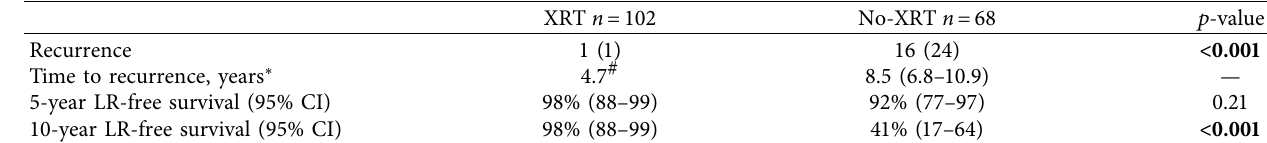
Table 2: Recurrence outcomes.